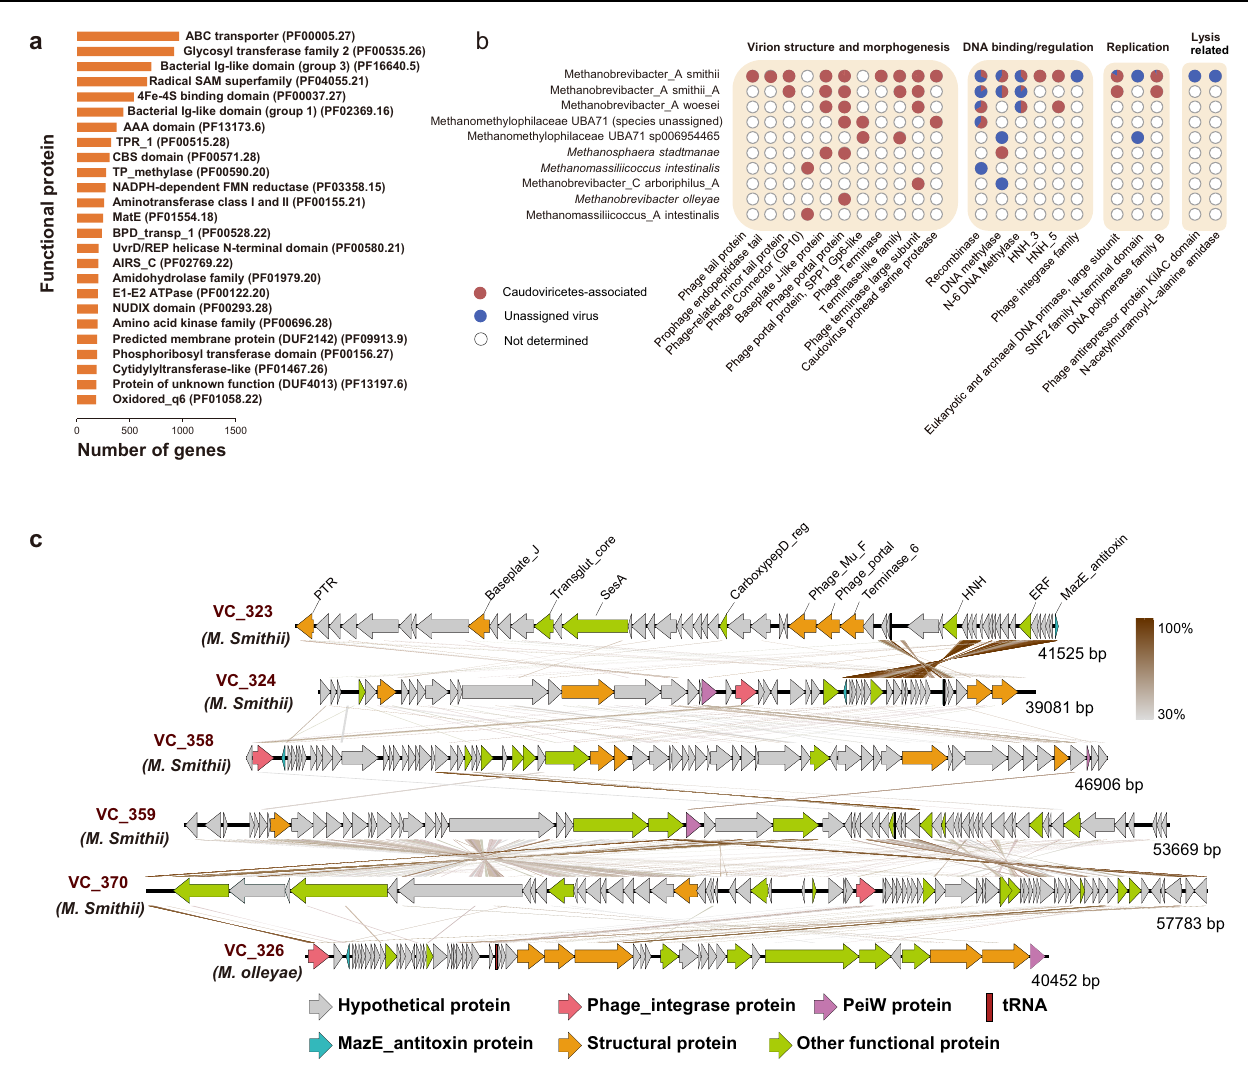
Fig.4|FunctionallandscapeoftheHGAVDviruses.a Functionalannotationsfor theproteinsencodedbythearchaealviruses. b Distributionof22genes 33 (lowerx- axis) on the viruses (y-axis). Filled circles indicate annotated orthologs (red:blue ratio represent the Caudoviricetes :Unassigned virus ratio), while white circles indicate thatthe ortholog was notidenti fi ed. c Genetic maps of the representative complete Caudoviricetes genomes for the 6 VCs (provir|Feng_Q_2015_NC_ERR6 88567.NODE_108_91642_1, provir|Feng_Q_2015_NC_ERR688611.NODE_45_142494_1, GPD|uvig_418233, IMG|UGV-GENOME-0318983, IMG|UGV-GENOME-0327529, HMP.763678604.contig63623_40452). The arrows depict the location and direc- tion of predicted proteins on the viral genomes, and the fi lled colors indicate